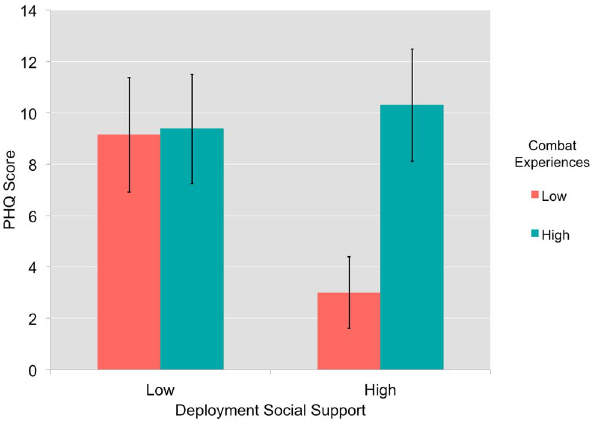
Figure 1. Interaction between deployment social support and combat experiences regarding post-deployment depressive symptoms. There was trend interaction effect for scores on the deployment social support and combat experiences subscales of the Deployment Risk and Resilience Inventory (DRRI) on depressive symptoms as measured by the Patient Health Questionnaire (PHQ), with a greater level of social support relating to less depressive symptoms for those with low combat experiences ( t (27)=1.86,two- tailed p=.074).